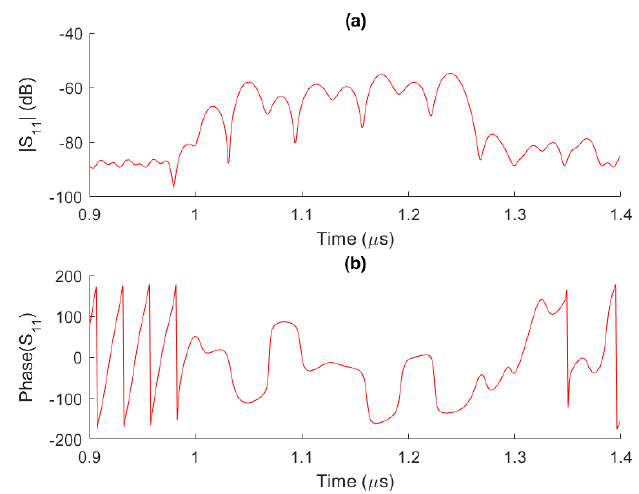
Figure 6. Amplitude ( a ) and phase ( b ) responses of the fabricated sensor in the time domain.